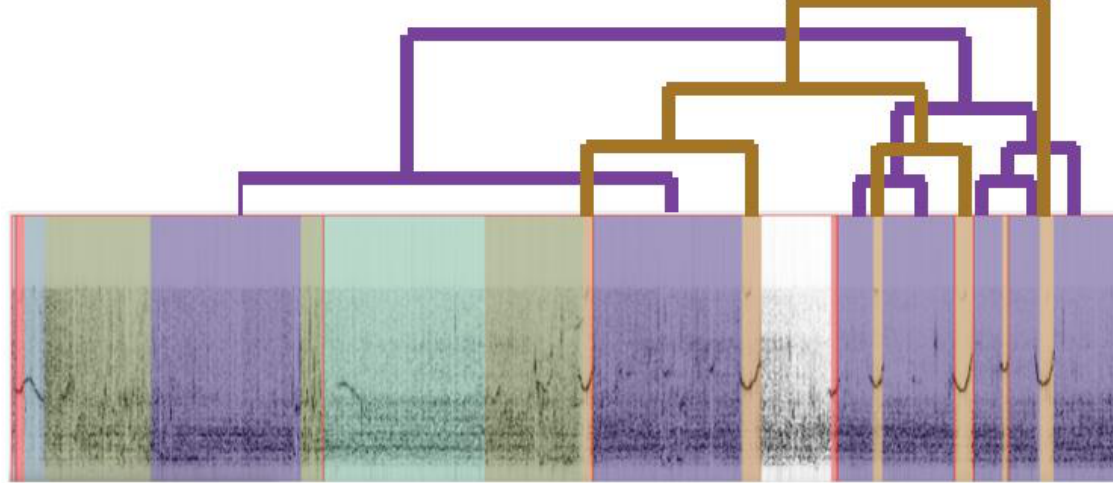
Figure 15. Hierarchical clustering of regions in dolphin